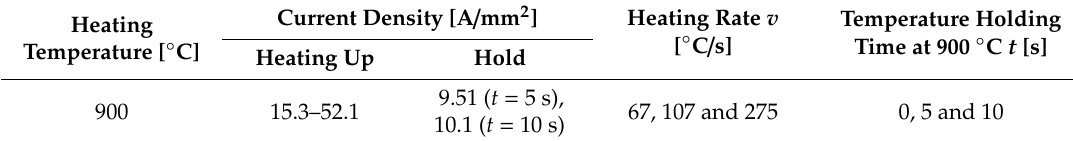
Figure 5. Heating path used for hot stamping using direct resistance heating. Table 2. Conditions of resistance heating used for hot stamping.